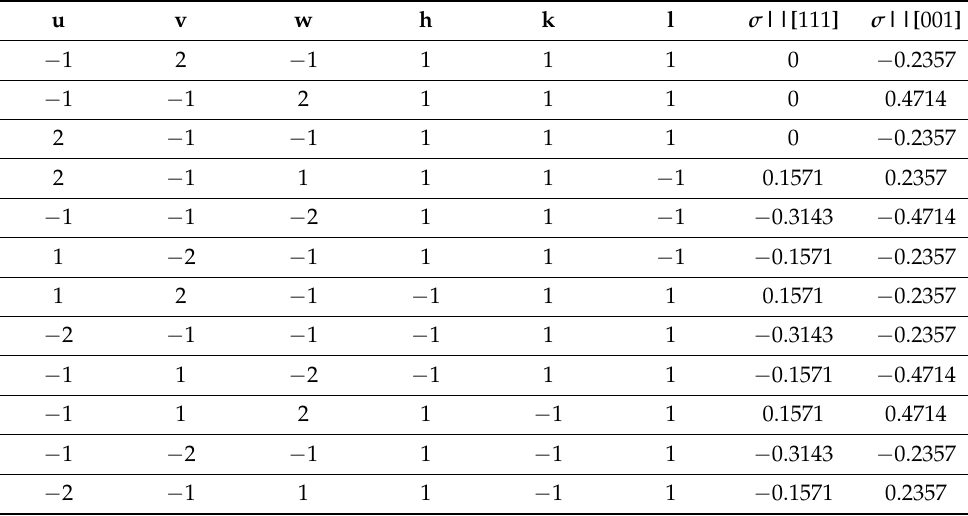
Table 3. Schmid factors of partial dislocations on the {111} with tension along [111] and